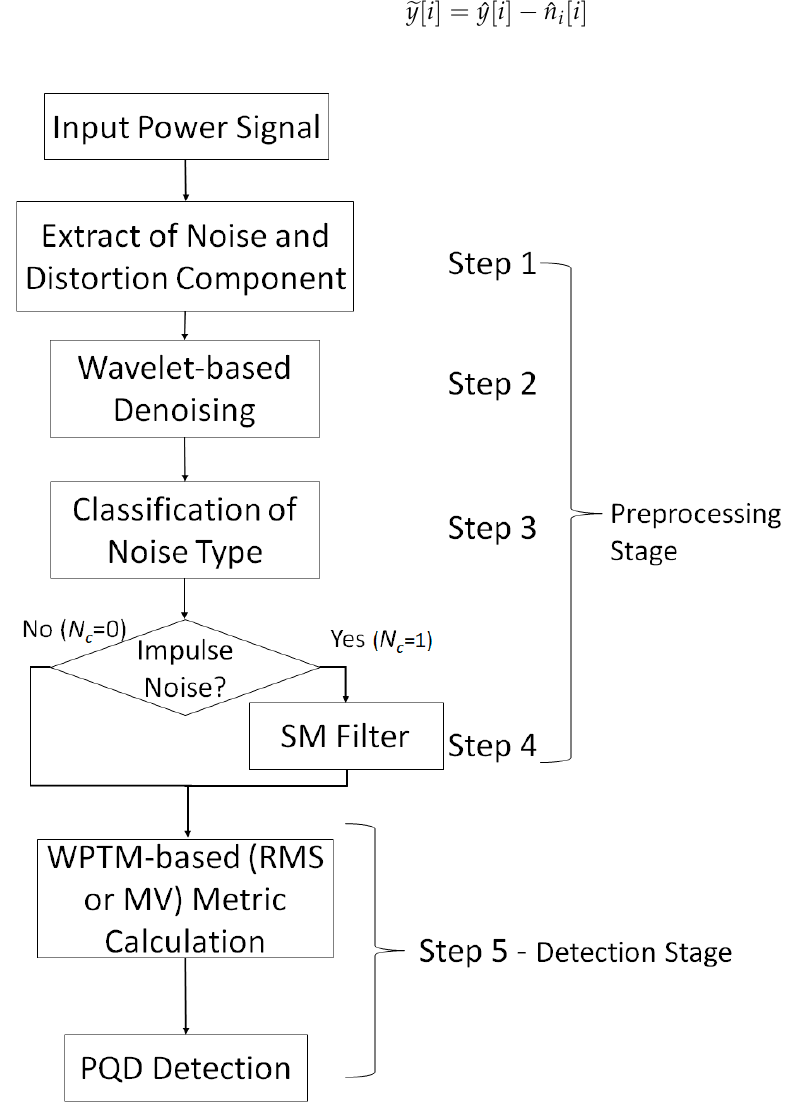
Figure 1. Flowchart of the proposed PQD feature detection with adaptive impulsive denoising.